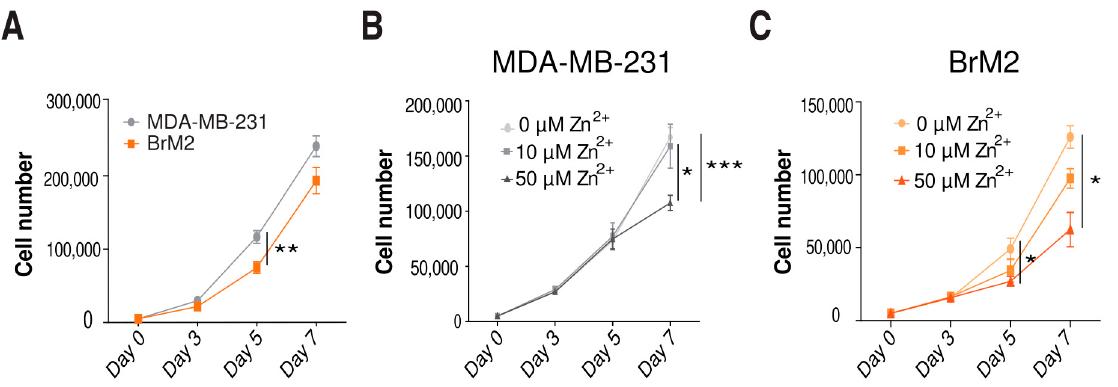
Figure 4. Proliferation assays in basal conditions and with changed zinc concentration. ( A ) Proliferation analysis comparing MDA-MB-231 and BrM2 cells. Cells were counted on days 3, 5, and 7 ( n = 15–18); ** p < 0.01 using t-test. ( B ) Proliferation analysis comparing MDA-MB-231 cells growing in 0, 10, and 50 µM of ZnSO 4 . Cells were counted on days 3, 5, and 7 (n = 9–15); * p < 0.05, *** p < 0.001 using t -test. ( C ) Proliferation analysis comparing BrM2 cells growing in 0, 10, and 50 µM of ZnSO 4 . Cells were counted on days 3, 5, and 7 (n = 6); * p < 0.05 using t -test.